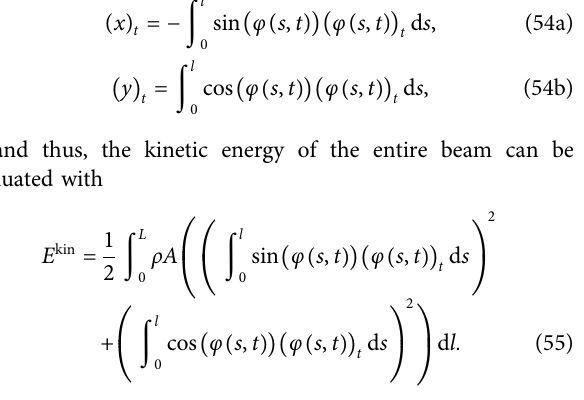
and again at the beam center, with a maximal unit force f ext over a perturbation time of t max (cid:2) 0 . 5 s. The result of the dynamic simulation with 10 beam elements is shown in Figure 5 . While in the fi rst 0.5 s, energy is injected in the system via the external perturbation, the resulting beam movement results in an energy exchange between kinetic and potential along the beam while conserving the total amount of energy in the system. Note that no dissipative terms such as damping are considered in the simulated beam (Eq. 21) . The right plot of Figure 5 shows the energy distribution within the entire beam at t (cid:2) 1 m. The accumulation of potential energy at the clamped site of the beam again demonstrates the effectiveness of the position boundary condition expressions Section 3.4 .